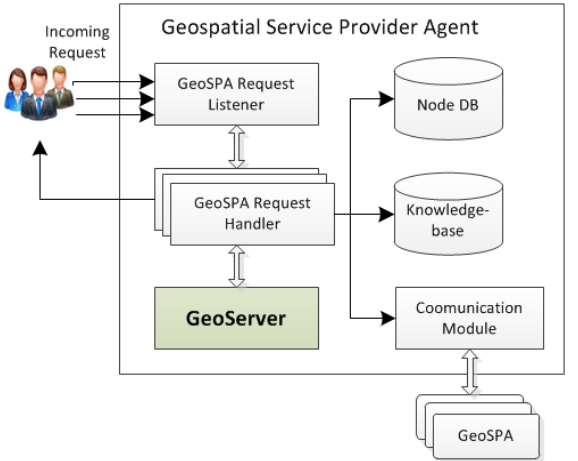
Figure 1. Internal structure of